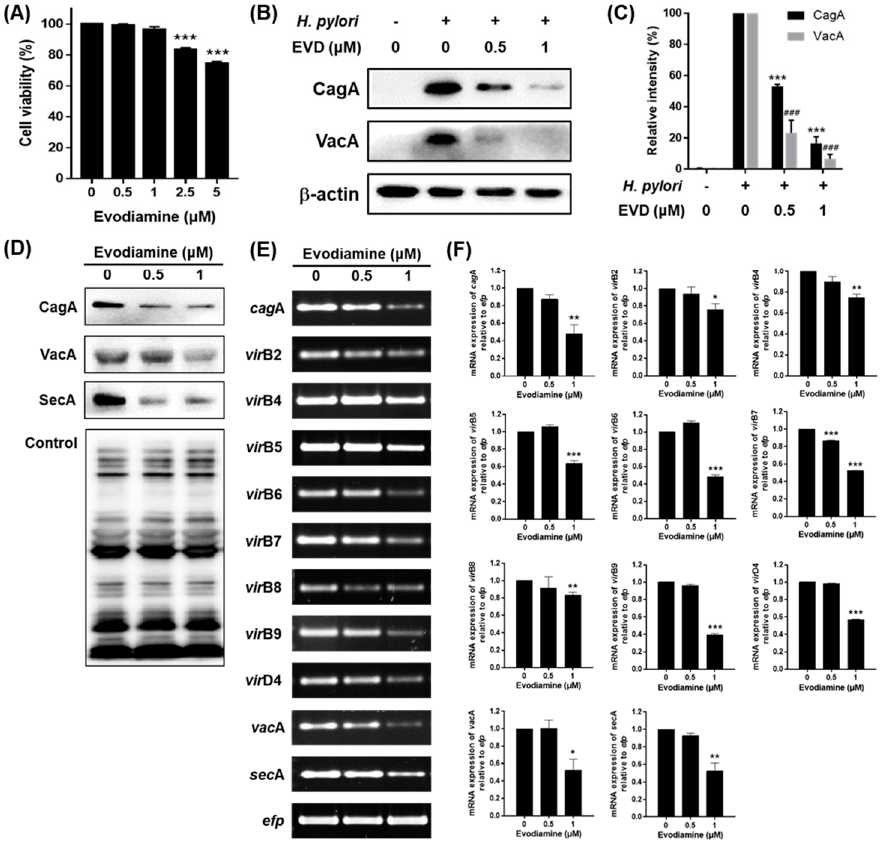
Figure 3. The inhibitory effects of evodiamine on CagA and VacA translocation to the gastric cell line. ( A ) AGS gastric cancer cells were treated with indicated dose of evodiamine (0.5, 1, 2.5 and 5 μ M) for 24 h and cell viability was measured by the WST assay. AGS cells were infected with H. pylori (200 MOI) and treated with indicated concentrations of evodiamine (0.5 and 1 μ M) for 24 h. ( B ) After incubation, the cell lysates were collected and Western blot was then performed to detect CagA and VacA proteins. β -actin was used as an internal control. ( C ) Each band intensity was normalized to β -actin. H. pylori was treated with indicated concentrations of evodiamine (0.5 and 1 μ M) for 72 h. ( D ) The cell lysates were subjected to Western blot to detect CagA, VacA and SecA. The rabbit anti- H. pylori polyclonal antibody was used as an internal control. ( E ) RNA was subjected to RT-PCR to detect the mRNA expression level of cag A, T4SS components, vac A and sec A. The expression of efp was used as an internal control. ( F ) Each band intensity was normalized to efp . Data were presented as mean ± SEM of three independent experiments and analyzed by Student’s t -test ( ### p < 0.001, * p < 0.05, ** p < 0.01 and *** p < 0.001).